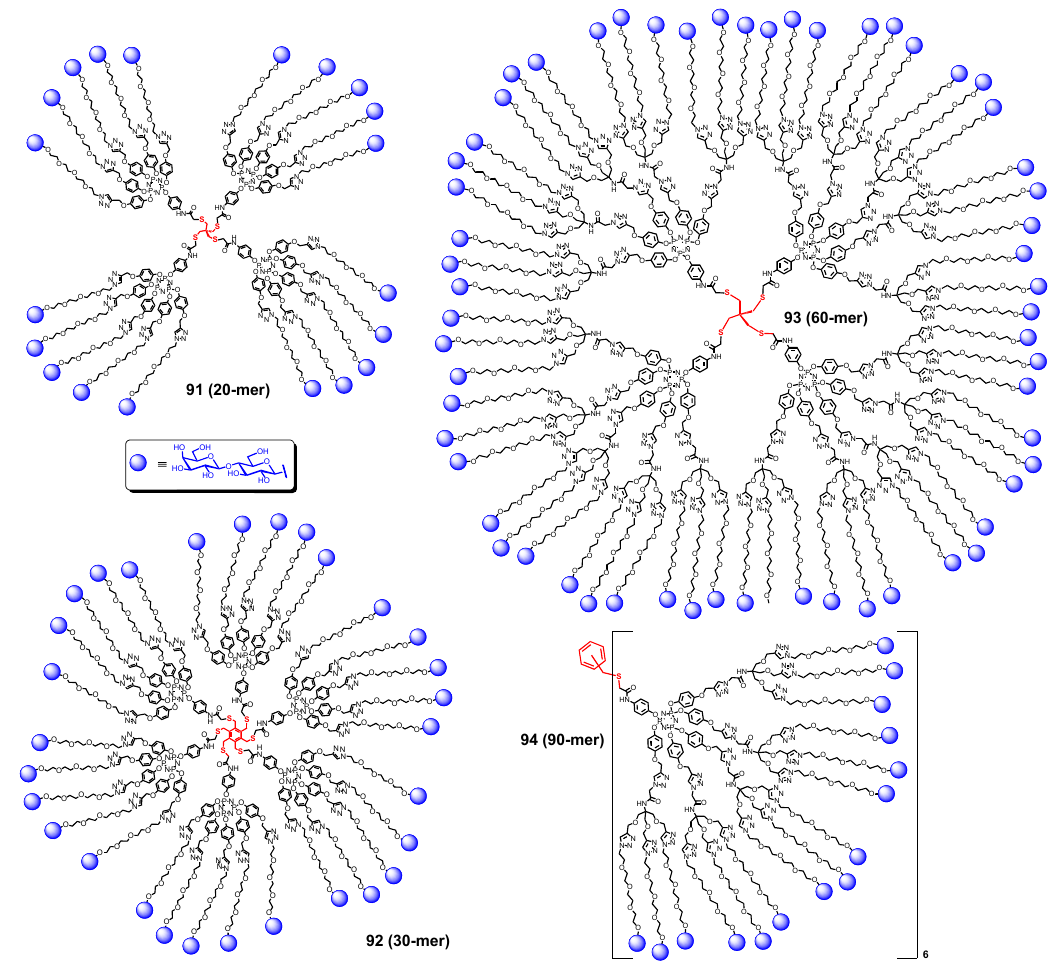
Scheme 20. Illustration of the structures of variations of the theme to build glycodendrimers with the same core as in Scheme 18 harboring 20 ( 91 ), 30 ( 92 ), 60 ( 93 ), and 90 ( 94 ) lactoside residues. The size of the glycodendrimers containing both the acetylated and the deprotected functionalities, and more particularly their solvodynamic radii, was estimated by pulsed-field-gradient stimulated echo (PFG-STE) NMR experiments using bipolar pulse pairs longitudinal-eddy-current delay (BPP-LED) in CDCl 3 and D 2 O, respectively, at 25 °C, as described in detail [126]. Diffusion values were determined by the average of individual values corresponding to the decay of the signal intensity of different protons located at different level in the molecule. The resulting measurements were consistent with spherical and unimolecular character of the glycodendrimers. The Stokes–Einstein equation directly yielded the corresponding solvodynamic diameters using viscosities determined for pure deuterated solvents. As expected, diffusion data revealed the increase of solvodynamic diameters as the number of peripheral epitopes was enhanced, under similar solvent conditions, showing dendrimers with solvodynamic diameters ranging from 2.6 to 10.1 nm. Systematic monitoring of bioactivity with the CRD of galectin-3, physiologically a product of proteolytic processing that removes the N-terminal tail (please see Figure 3), revealed ligand property for all compounds. As noted above for starburst glycodendrimers, the relative potency per sugar unit was highest at low to medium level of valency, here for the dumbbell-shapes decavalent 83 (r.p./sugar = 53) of a diameter of 5.3 nm [126]. These examples document the ingenuity of chemical design to reach the level of giant clusters with a core. To take design even further into the direction of engineering vesicle-like structures, a different strategy has been successfully implemented.